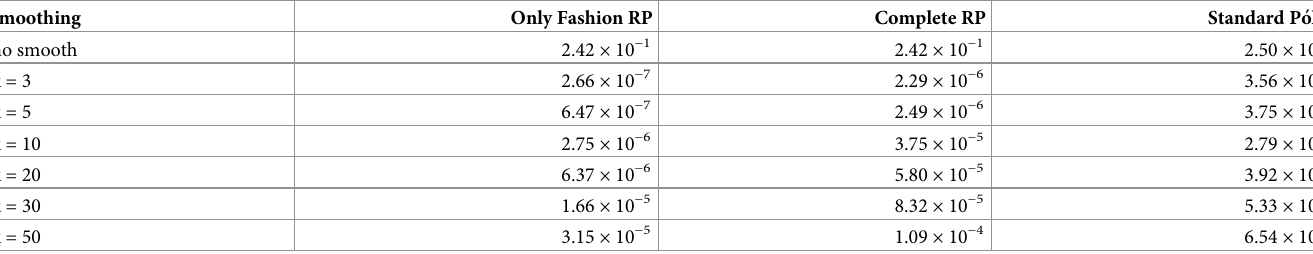
Table 17. “Migration” ( T = 0.5, entire, D = 3 0 , slots = days): MSE for different levels of smoothing. smoothing Only Fashion RP